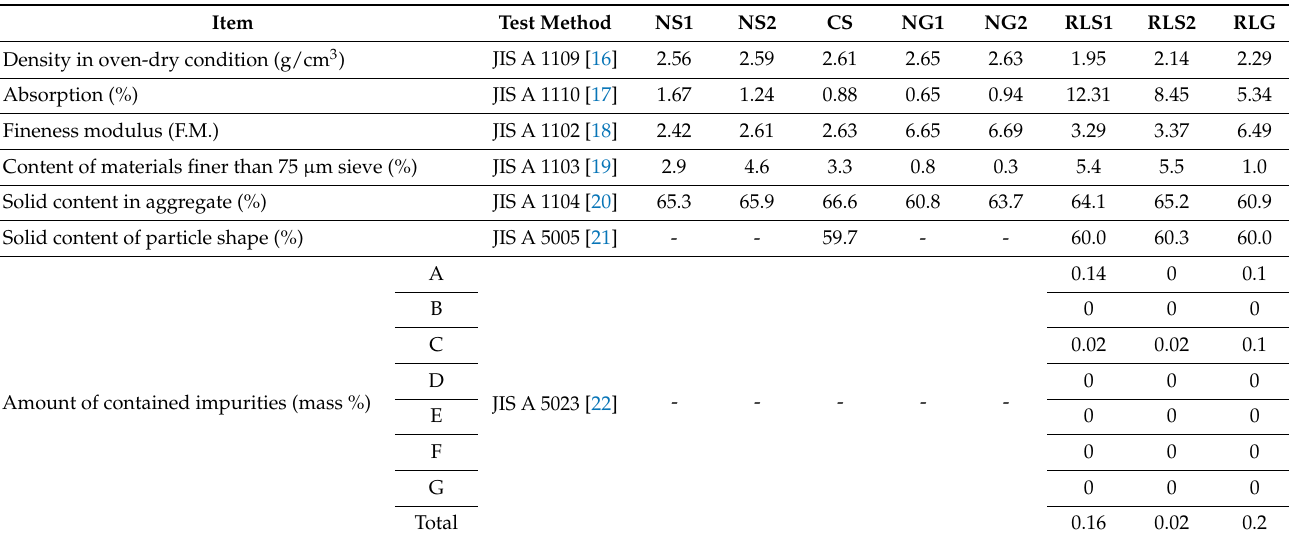
Table 4. Quality of